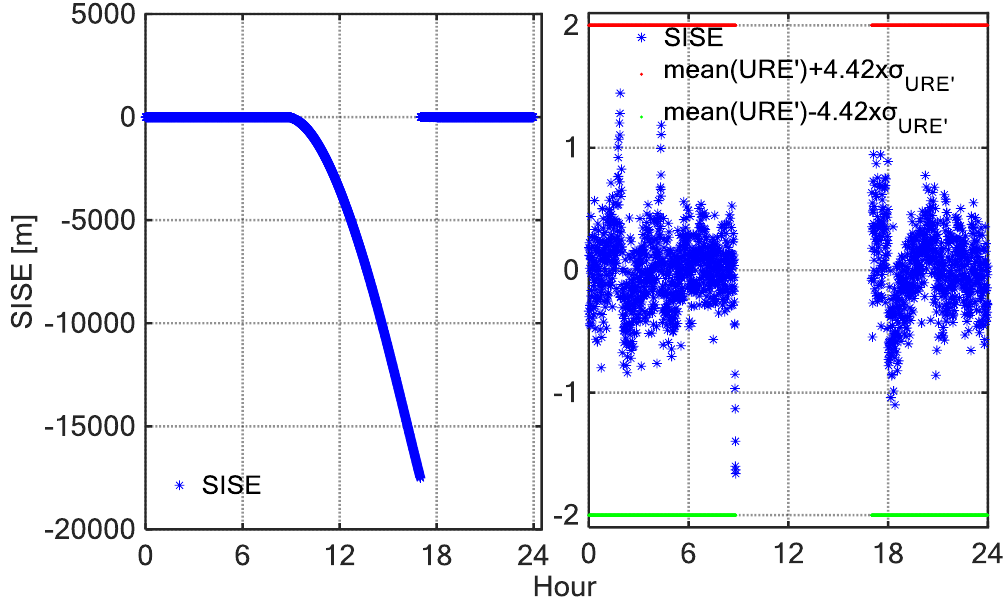
Figure 13. SIS-URE after eliminating the trend term time series as a function of BDT on day 359 of 2015 for BDS satellite C10 tracked by XMIS. Subplot ( left ) corresponds to the tracking data of satellite C10 by XMIS for the whole day, and subplot ( right ) corresponds to the tracking data of satellite C10 by XMIS with the anomalous periods removed.